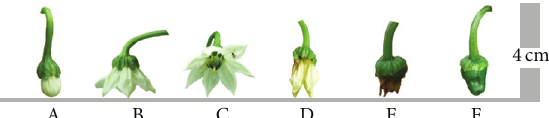
Figure 4: Flower developmental stages of chilhuacle chili. (A) Floral bud 1 day after pollination (DAP). (B) 2 DAP. (C) 4 DAP. (D) 5 DAP. (E) 7 DAP. (F) Fruit development 8